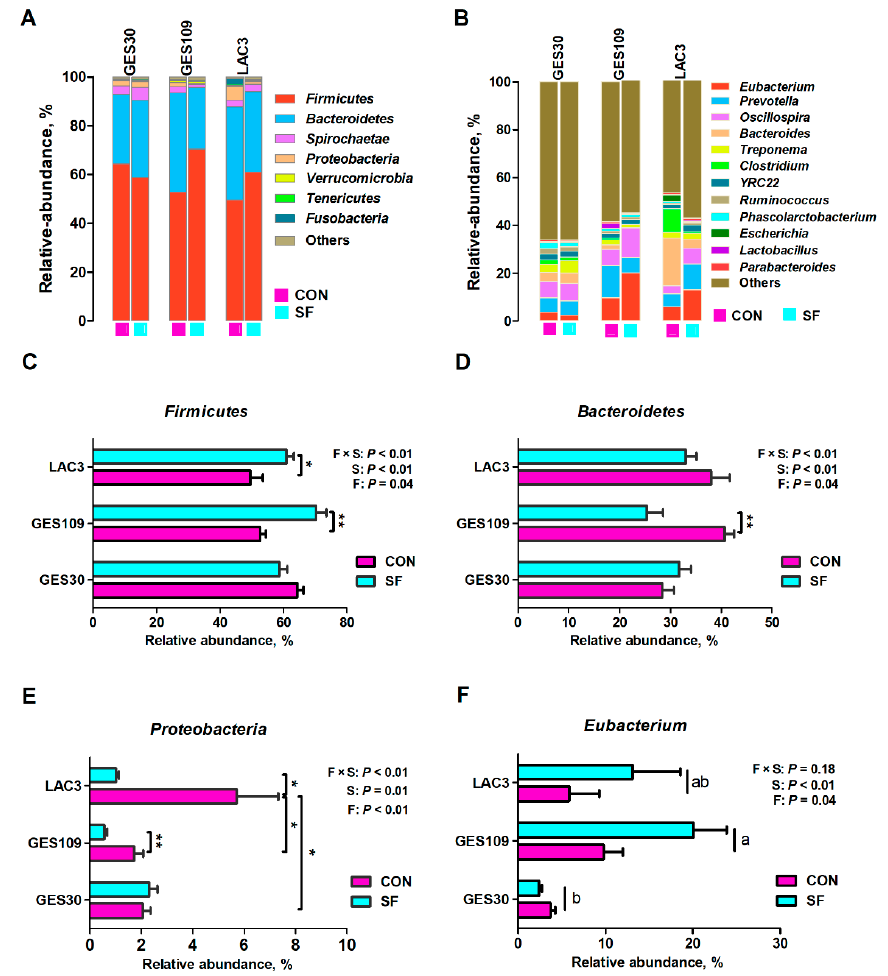
Figure 2. Effects of soluble fiber during gestation on gut microbiota composition of sows. The relative abundance of different phyla ( A ) and genera ( B ) in gut microbiota of CON and SF sows among different breeding stages. Comparison of phyla Firmicutes ( C ), Bacteroidetes ( D ), and Proteobacteria ( E ) and genus Eubacterium ( F ) between CON and SF sows during different breeding stages. Data are expressed as mean ± SEM ( n = 8). When significant main effects or interactive effects were observed, the means were compared using the least significant difference method with a p < 0.05 indicating significance. * p < 0.05; ** p < 0.01. a-b, significant effect of breeding stage ( p < 0.05; values with different lowercase letters are significantly different). GES109, day 109 of gestation; LAC3, day 3 of lactation.